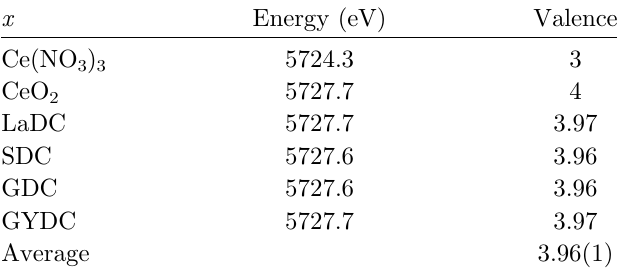
Table 6. Ce(NO ) , CeO and LaDC, SDC, GDC, and 3 3 2 GYDC sample powders with 1000 (cid:1) C treatment: Ce L -edge XANES spectrum single maximum differential energy shoulders and corresponding Ce